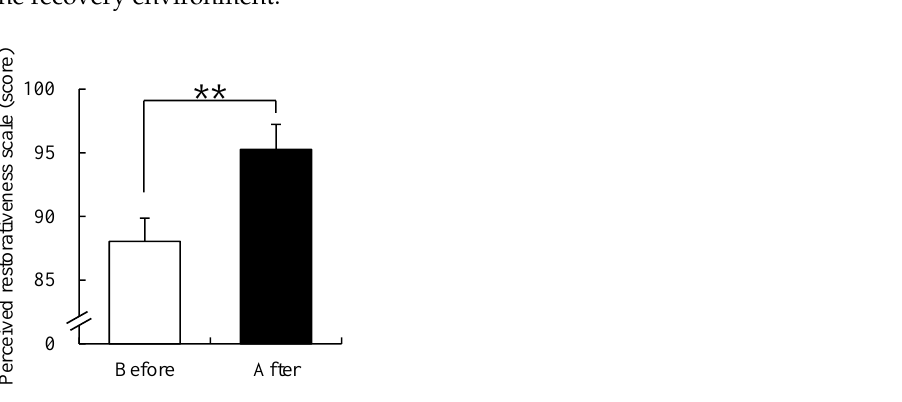
Figure 9. Changes in scores of the perceived restorativeness scale before and after the FCA. Data are presented as mean ± standard error ( n = 61). Significance was verified by Wilcoxon signed-rank test; ** p < 0.01.